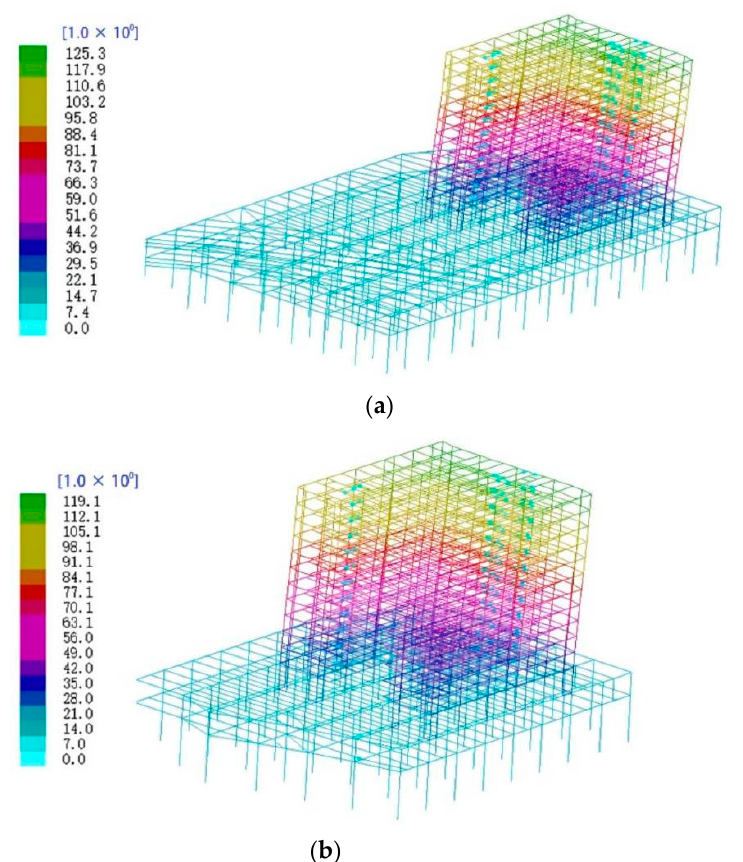
Figure 6. Horizonal displacements calculated by the global and local scales (unit: mm). ( a ) Global model. ( b ) Local model.